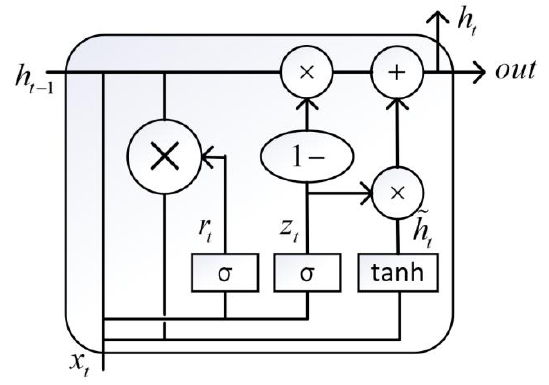
Figure 5. The structure of GRU cell.